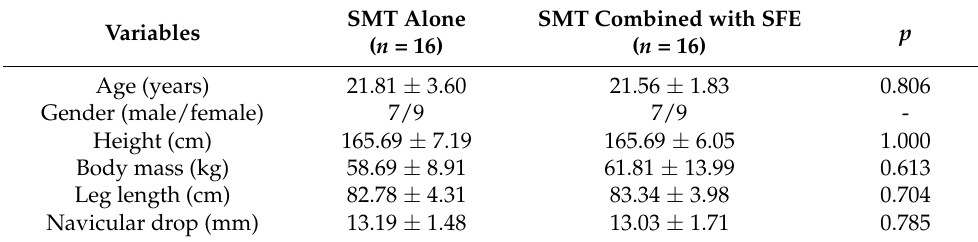
Table 2. Demographic and anthropometric characteristics of the subjects ( n =